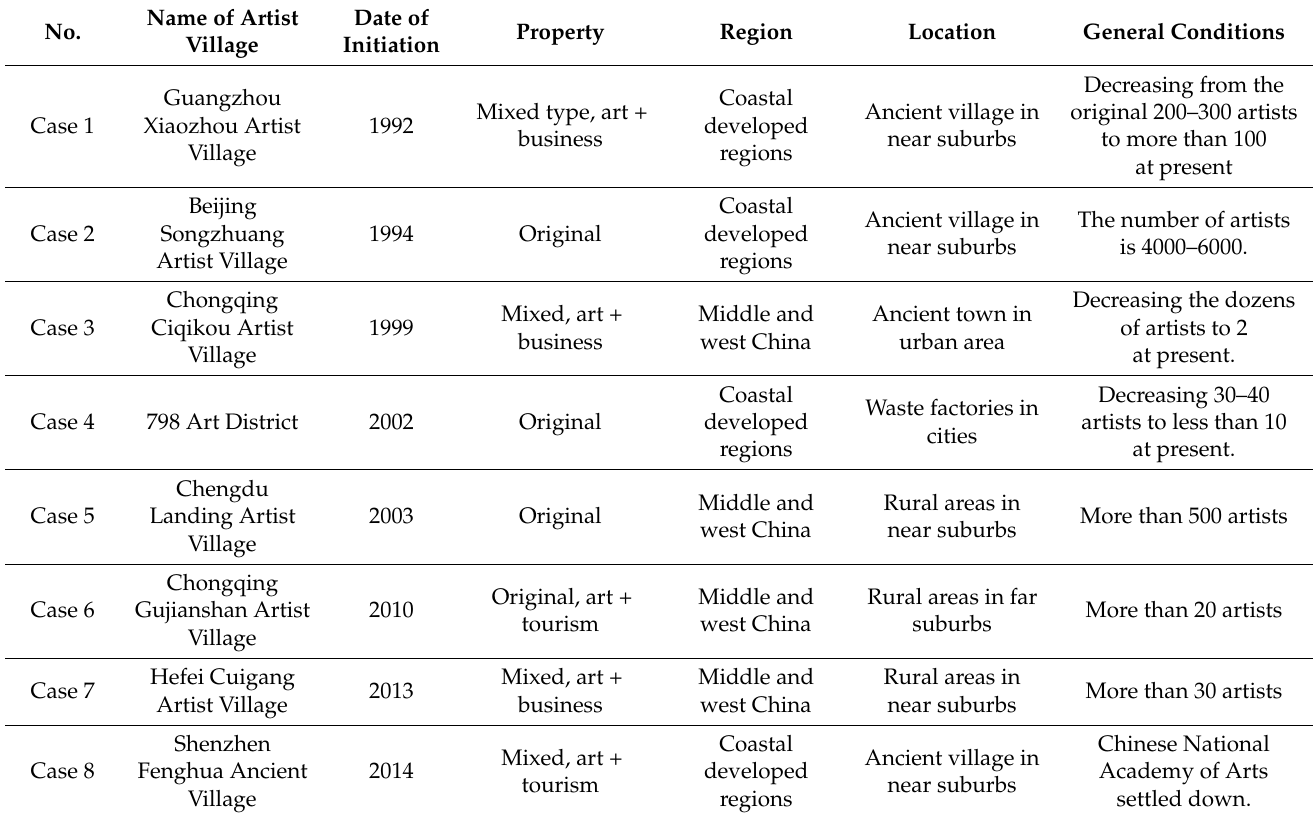
Table 2. General conditions of 8 Artist Villages in field investigation.